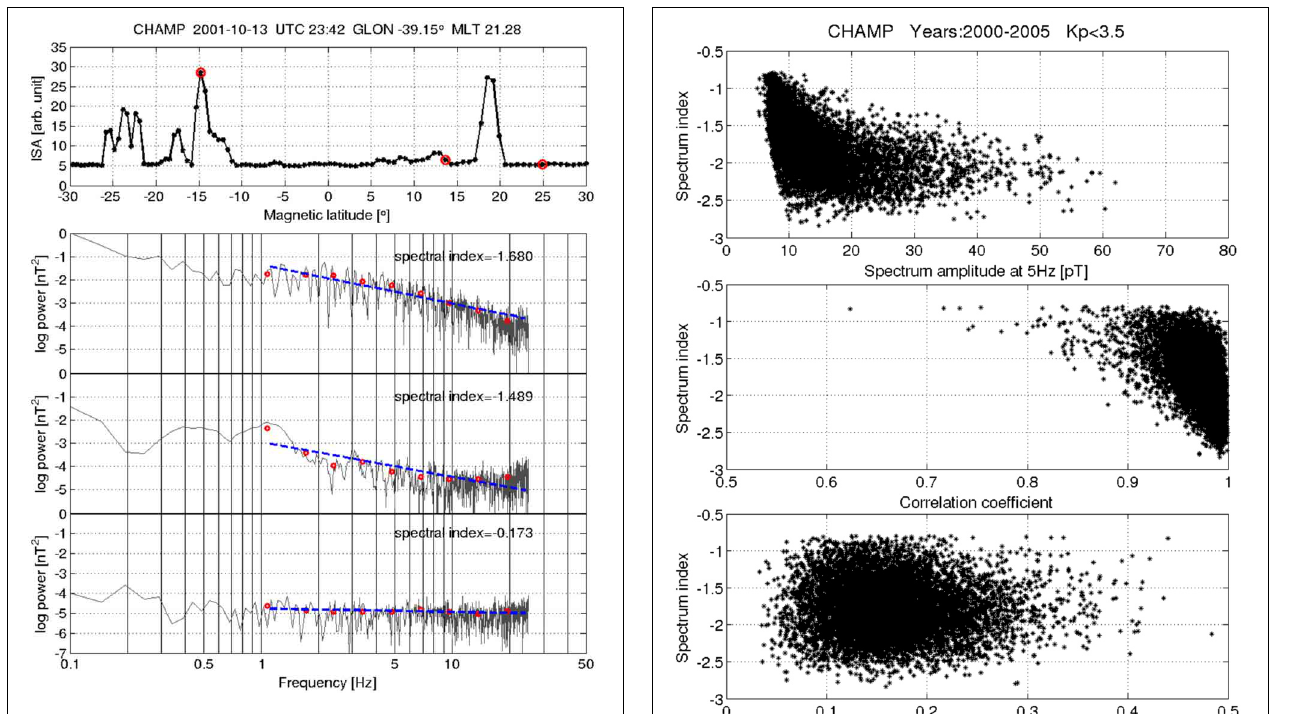
Figure 7 . The power spectral density, PSD, is assumed to follow a power law with frequency, f :